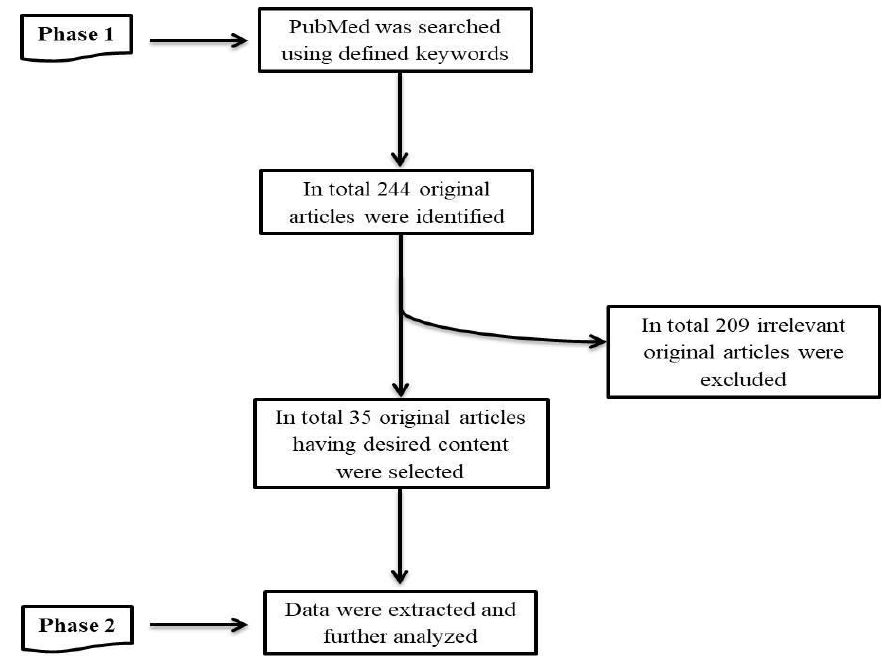
Figure 1: Overview of the methodology used in the present